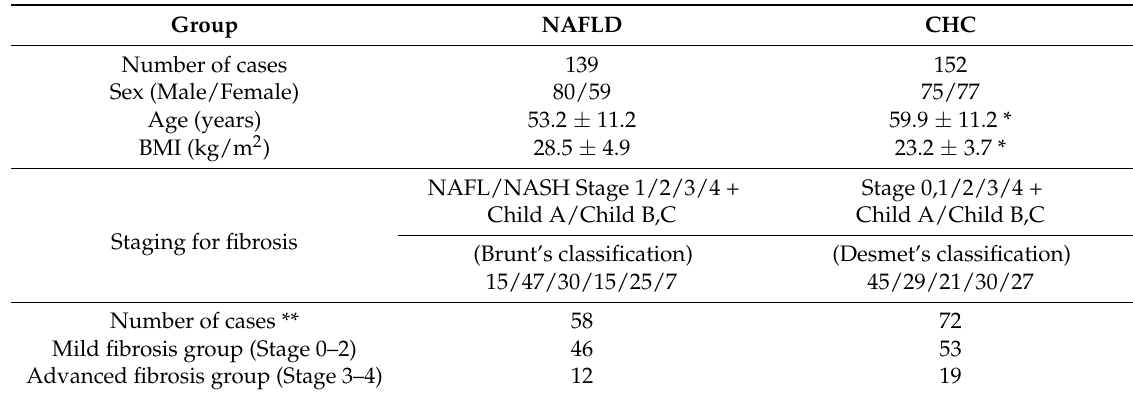
Table 7. Characteristics of